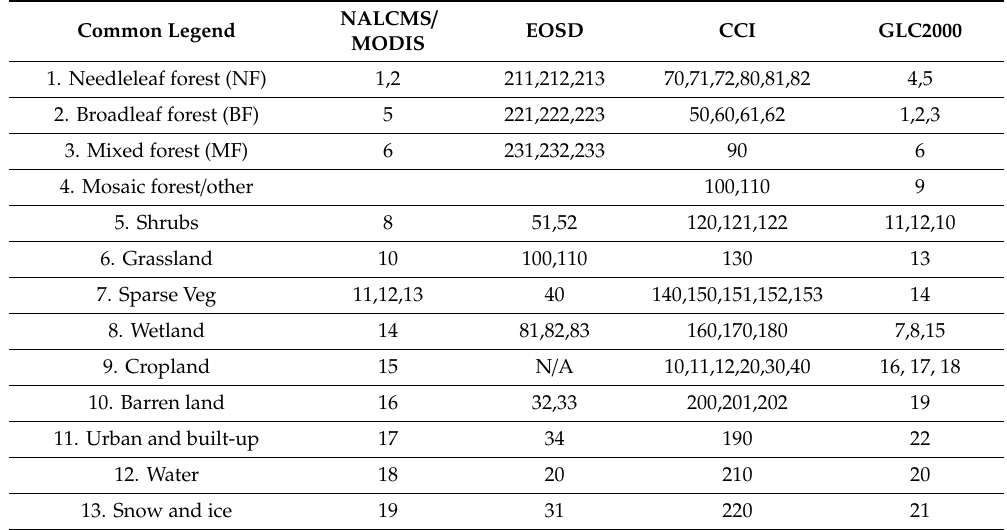
Table 3. The common legend and the merging rules for each land cover dataset.